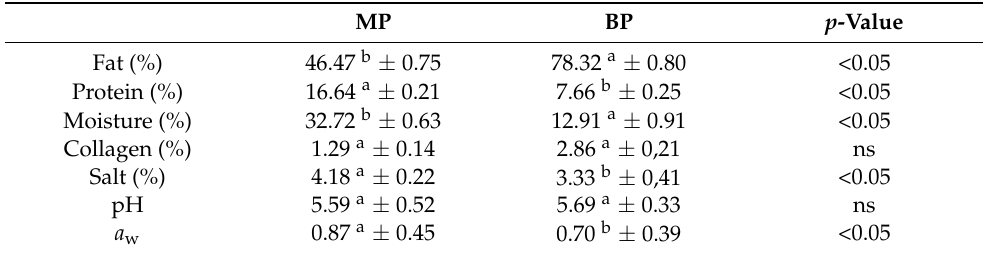
Table 1. Physical-Chemical Properties of Slavonska slanina . MP BP